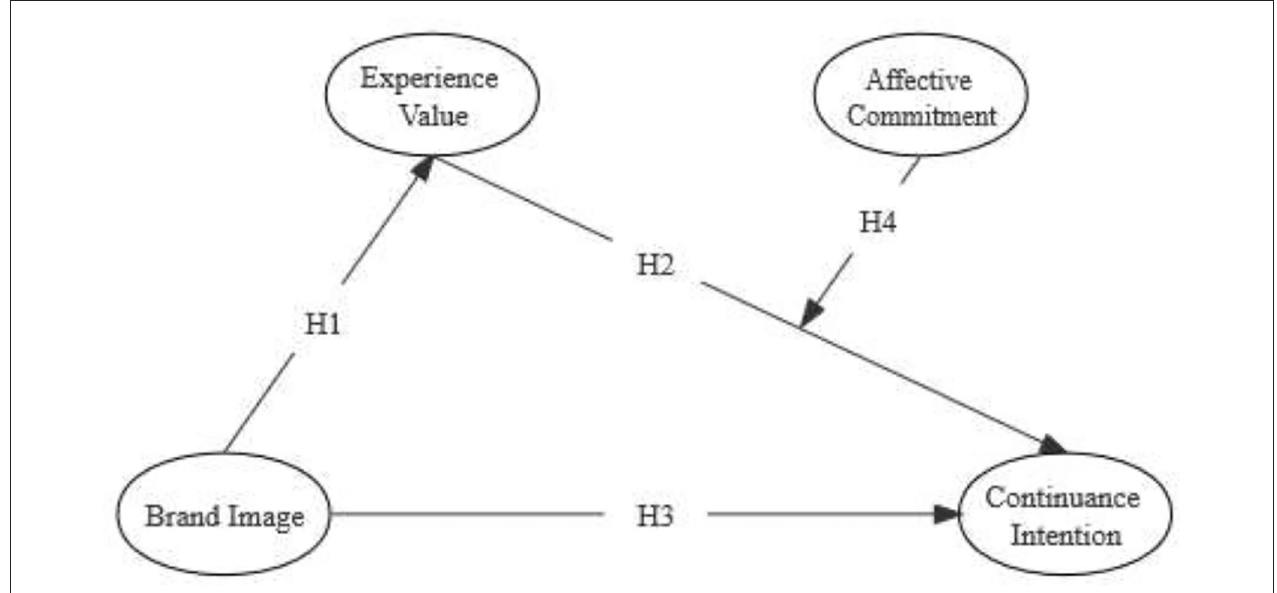
FIGURE 1 | Theoretical model.